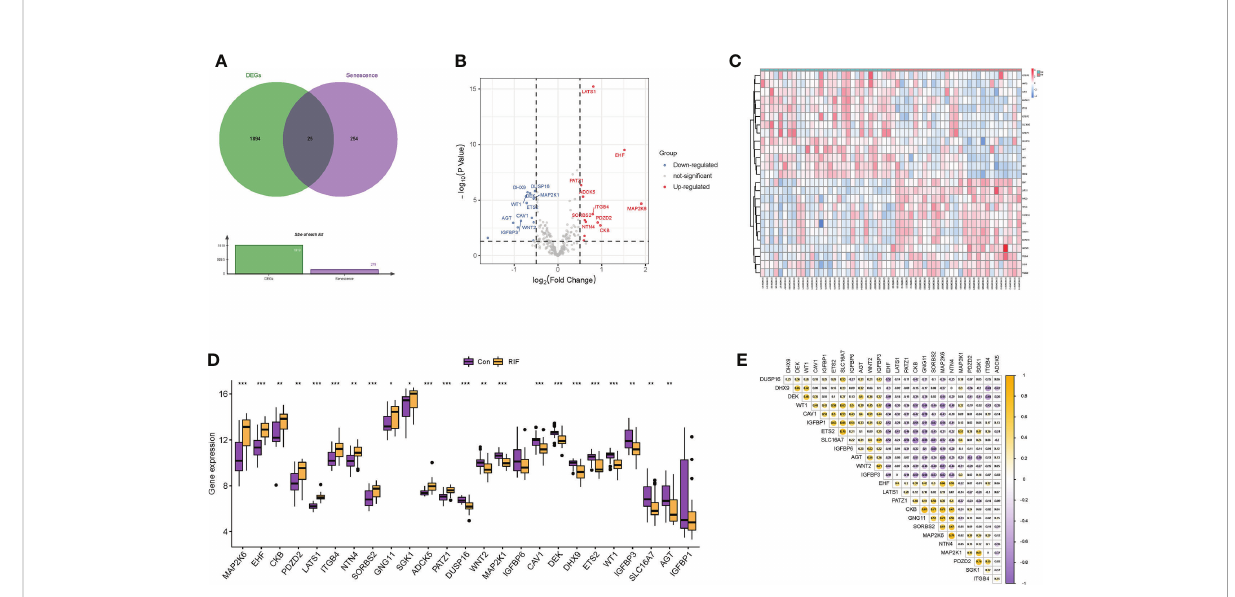
FIGURE 2 Identi fi cation of differentially expressed genes related to cellular senescence. (A) Venn diagram of differentially expressed genes and genes related to cellular senescence. (B, C) Volcano plot and heatmap visualized the differentially expressed genes (DEGs) related to cellular senescence. In the volcano plot, each dot represents a gene. The red plot points represent upregulated genes, and the blue plot points represent downregulated genes, and in the heatmap, each row represents a DEG related to cellular senescence, and each column represents a sample. (D) The difference in the mRNA expression pro fi ling of cellular senescence-associated DEGs between the recurrent implantation failure (RIF) and control groups. ( E ) The correlations between cellular senescence-associated DEGs in the RIF group. * represents P < 0.05 compared with the control group, ** represents P < 0.01 compared with the control group, and *** represents P < 0.001 compared with the control